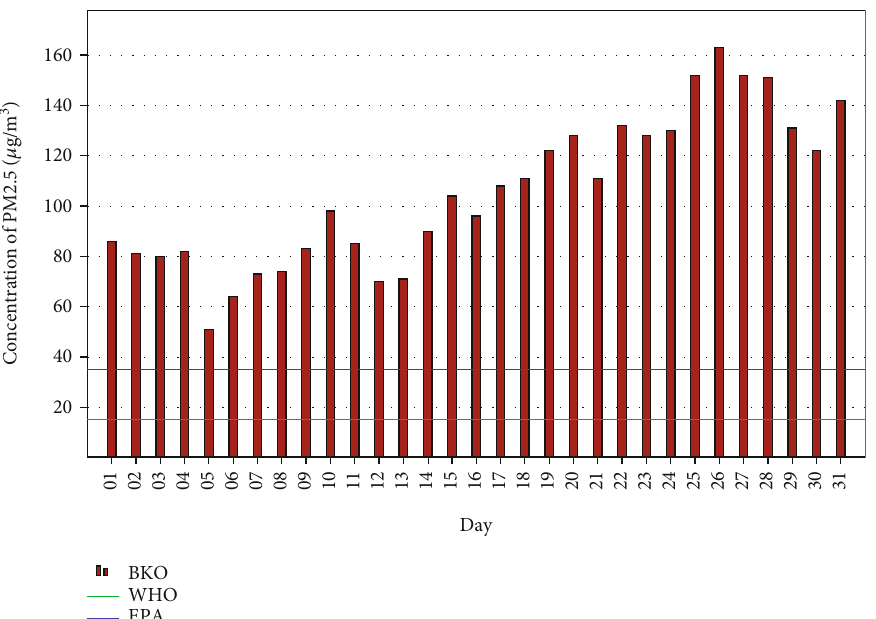
Figure 2: Daily averaged concentration of PM2.5 in Bamako over October 2020. Source: based on EPA (Bamako Air Quality Monitor - US Embassy) and the World Air Quality Index Project database